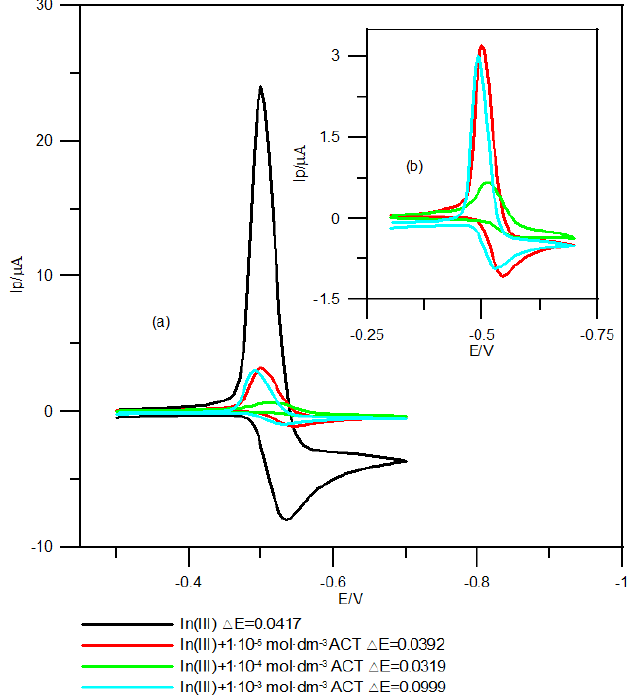
Figure 3. ( a ) Cyclic voltammograms of 1 × 10 − 3 mol · dm − 3 In(III) electroreduction in the 1 mol · dm − 3 chlorates(VII) solution in the acetazolamide presence. ( b ) Cyclic voltammograms of 1 × 10 − 3 mol · dm − 3 In(III) electroreduction in the 1 mol · dm − 3 chlorates(VII) solution in the pres- ence of ACT without the basic electrolyte. The concentrations of acetazolamide, together with the corresponding peak potential separation values, are given on the plot. The scan rate was 50 mV s − 1 .